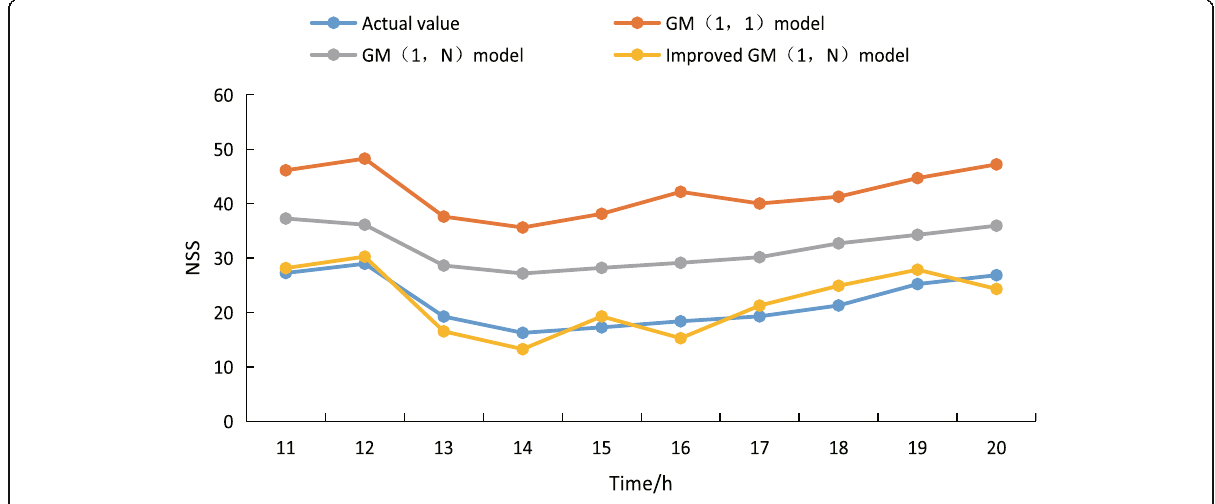
Fig. 1 Prediction results of different gray models